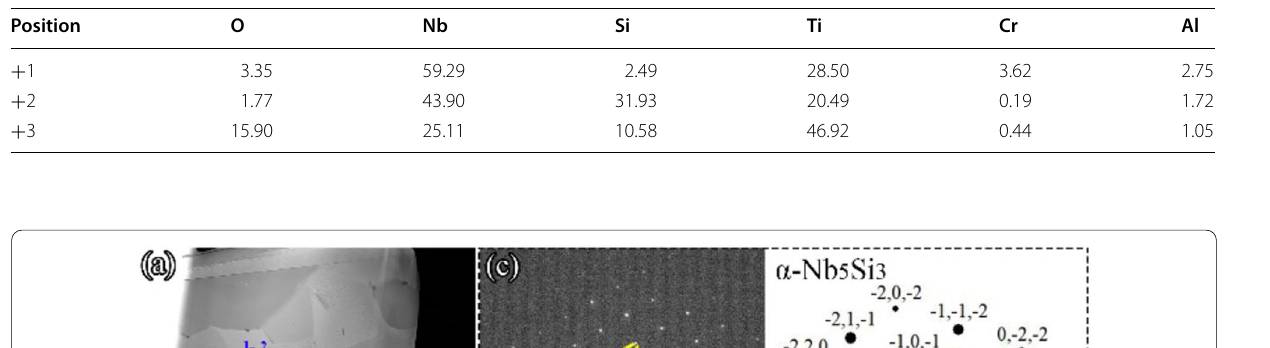
Table 1 Compositions of selected positions in Figure 5 for the EBSM Nb-Si based alloy after annealing at 1450 °C for 5 h measured by SEM-EDS (at.%)